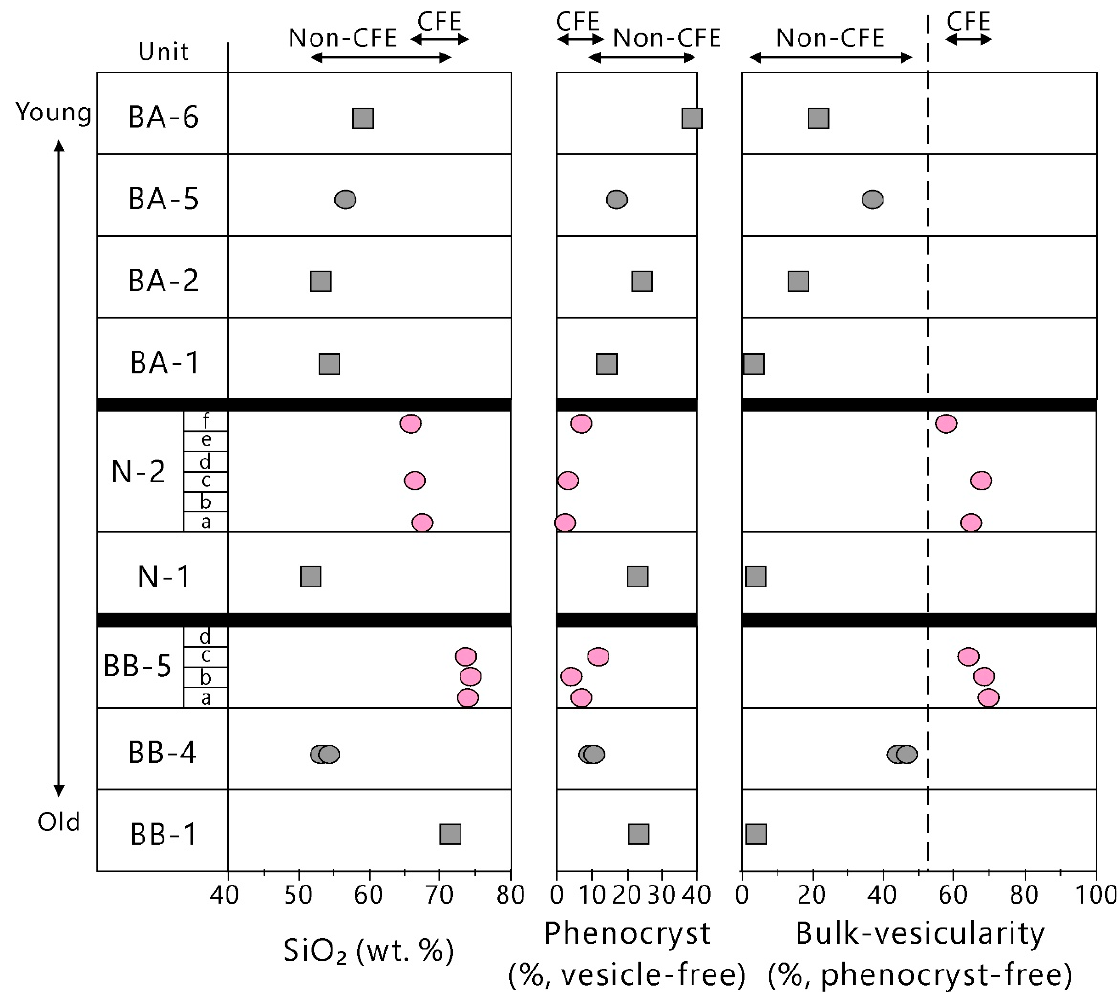
Figure 16. Temporal variation of bulk-rock geochemistry, pheno-crystallinity (vesicle-free), and bulk-vesicularity (phenocryst-free) of the BVC eruptive products. Note that the caldera-forming eruption (CFE) tends to occur under a highly evolved, aphyric, and gas-rich magmatic condition. At the same time, the non-caldera-forming eruption (non-CFE) was sourced from less evolved, crystalline, and gas-poor magmas.